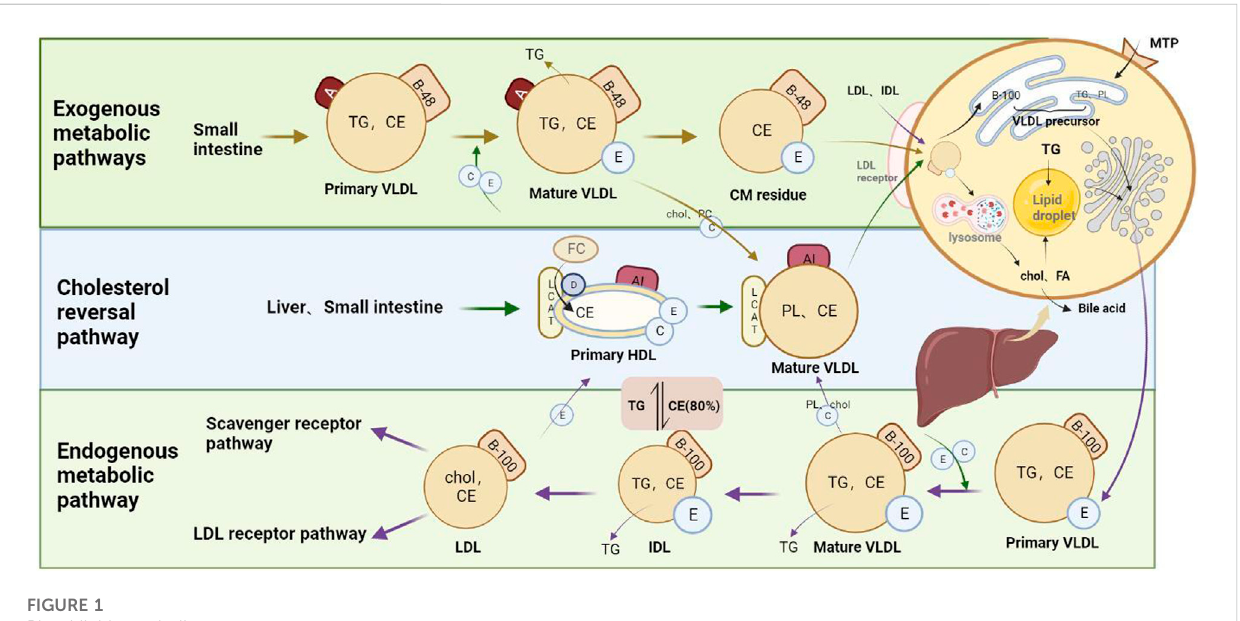
FIGURE 1 Blood lipid